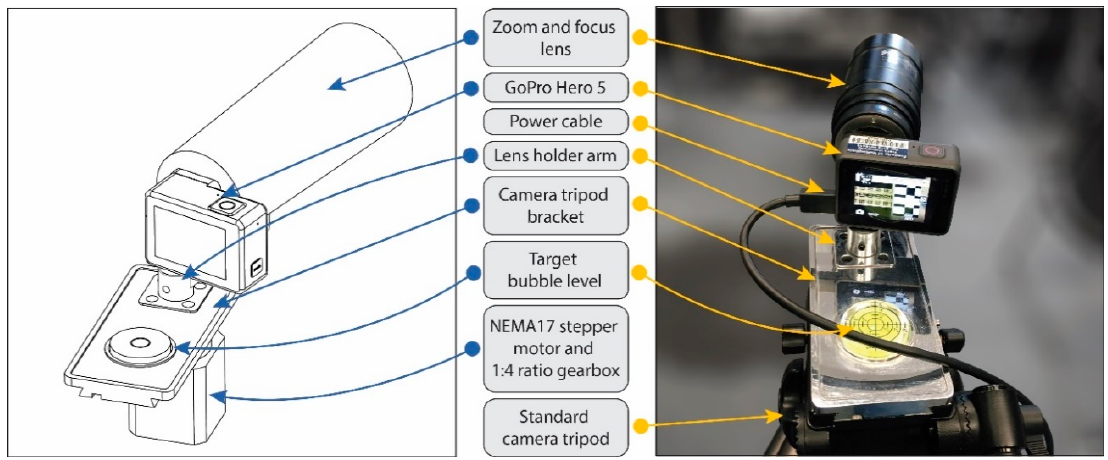
Figure 2. Proposed robotic camera system: design ( left ) and photo ( right ).